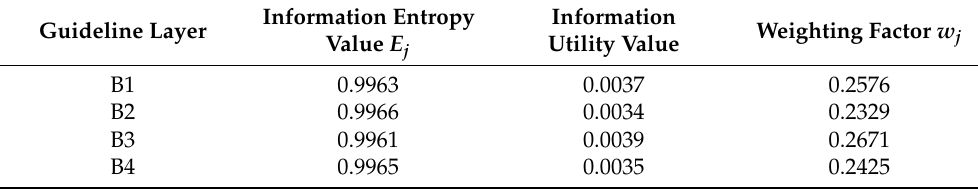
Table 12. Weight results of each criterion layer based on entropy